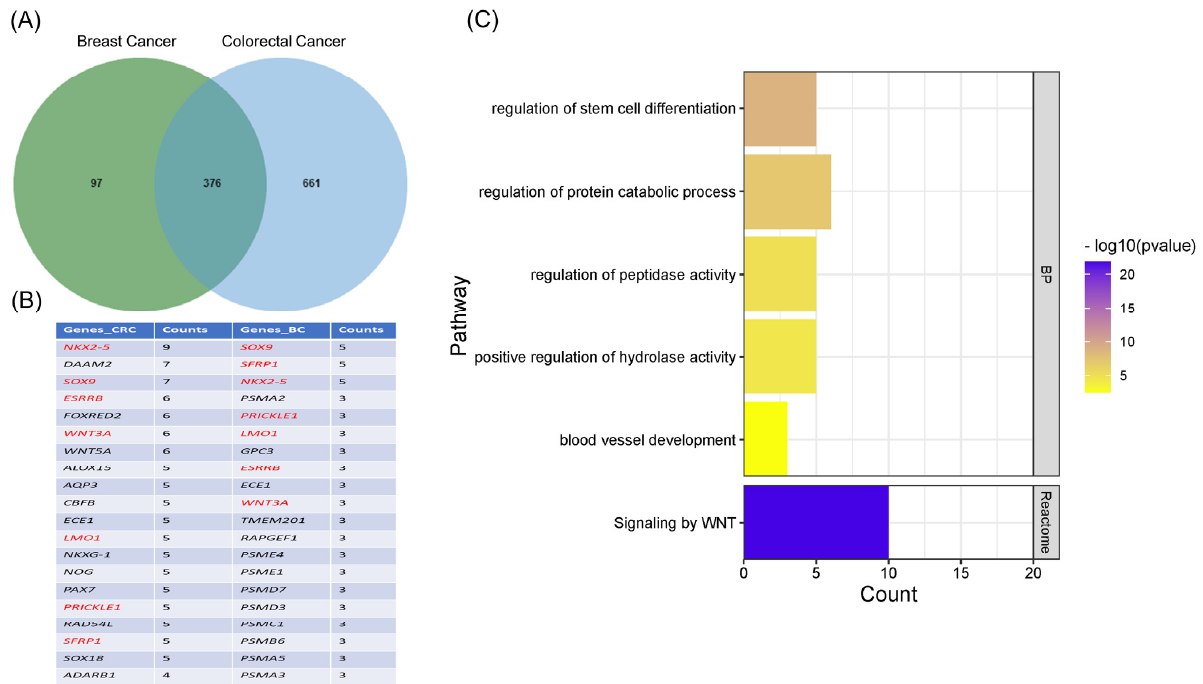
Figure 7. Top genes involved in the activated pathways of CRC and BC HER2+ vs. HER2 − patients revealed a significant resemblance. ( A ) Venn diagram representing the overlap of genes overrepresented in enriched pathways in CRC and breast cancer patients. ( B ) Table showing the top 20 enriched genes in breast cancer and CRC patients. Genes shown in red were common in both CRC and breast cancer patients. ( C ) Related pathways of the top 20 enriched genes are shown. Representation is based on frequency in HER2 − vs. HER2+ CRC